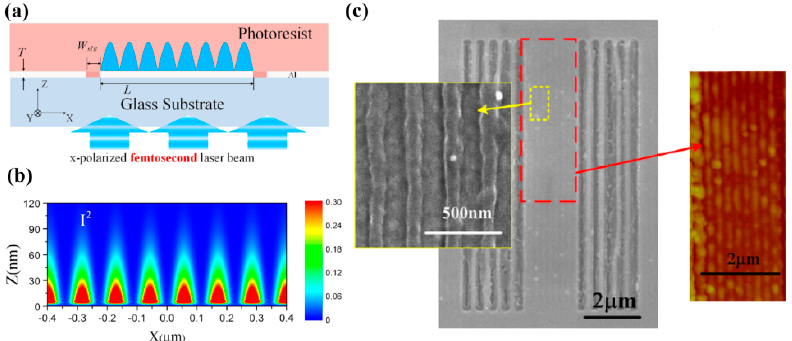
Figure 11. ( a ) Schematic structure of two-SPPs absorption interference lithography; ( b ) Simulated interference intensity distribution; ( c ) Experimental results of resist pattern. Reproduced from [60], Copyright © 2013, AIP.